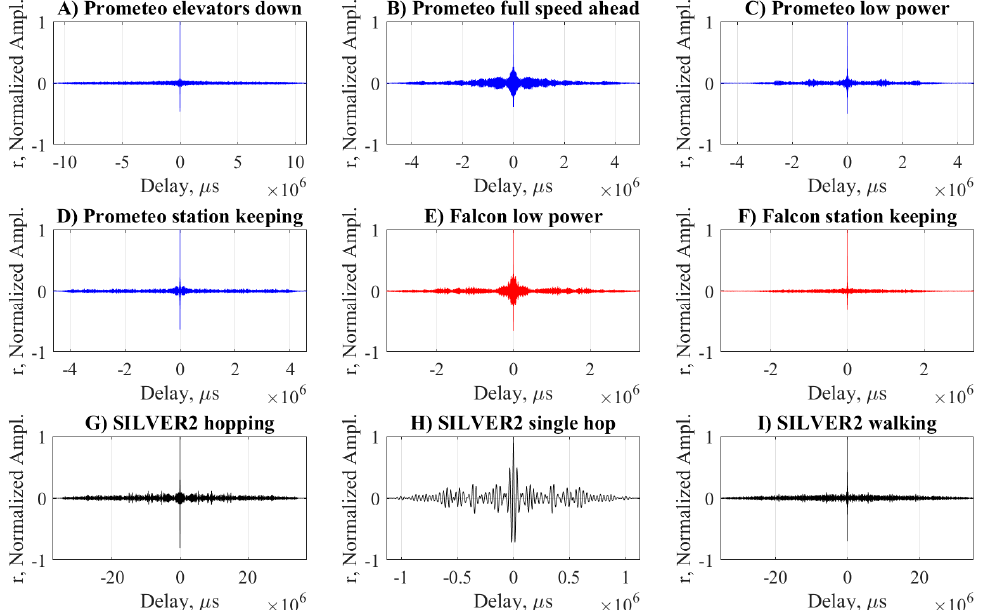
Figure 6. Autocorrelation coefficient r of the recordings of Prometeo (blue), Falcon (red), and SILVER2 (red) performing various maneuvers. Notice the different scale of the x -axis, required to keep a high resolution.